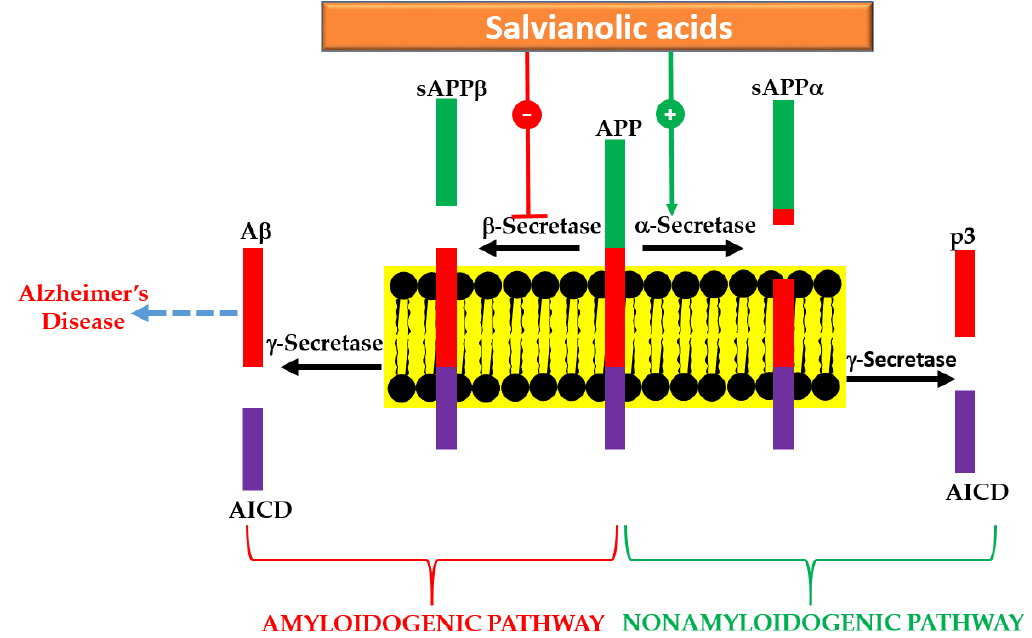
Figure 3. Anti-AD effect of salvianolic acids via Aβ formation. In the amyloidogenic pathway, APP